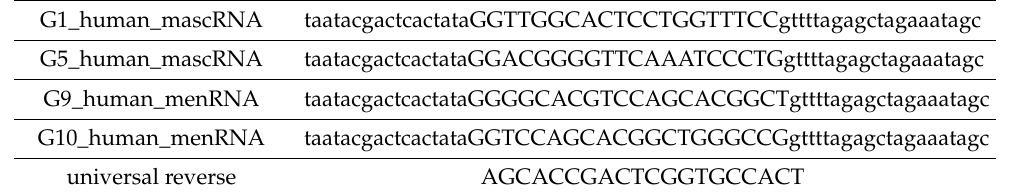
Table 1. sgRNAs employed for CRISPR-Cas9 deletion